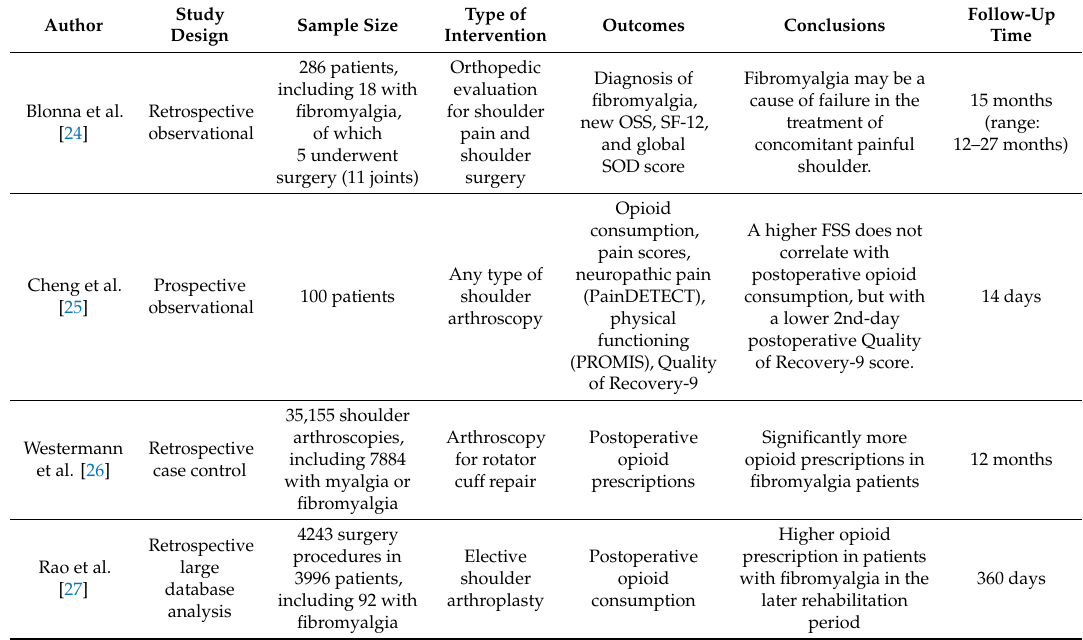
Table 2. Summary and comparison of search